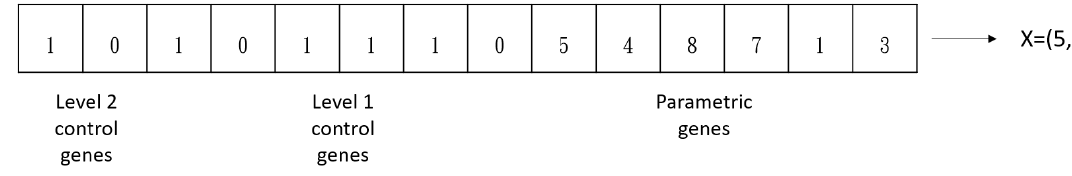
Figure 2. An example of chromosome representation.